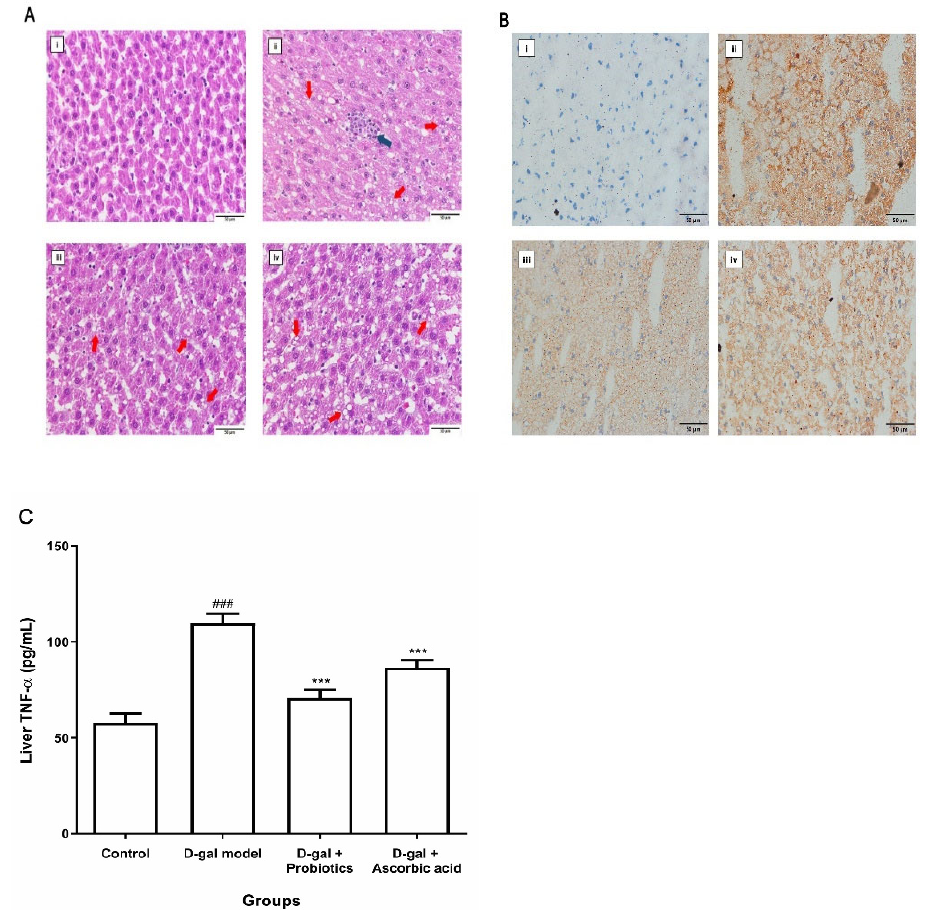
Figure 2. Protective effect of B. animalis MSMC83 and ascorbic acid on liver inflammation. Liver histopathological alterations with H&E staining ( A ) and Oil Red O staining ( B ), magnification 400×. Control group ( i ), D-gal model group ( ii ), D-gal plus probiotic group ( iii ), D-gal plus ascorbic acid group ( iv ). Red arrows indicate macrovesicular fat droplets; blue arrow indicates inflammatory infiltration. ( C ) Tumor necrosis factor α in oxidative stress rats. Data are presented as means ± SD ( n = 5). ### p < 0.001 as compared with the control group. *** p < 0.001 as compared with the D-gal model